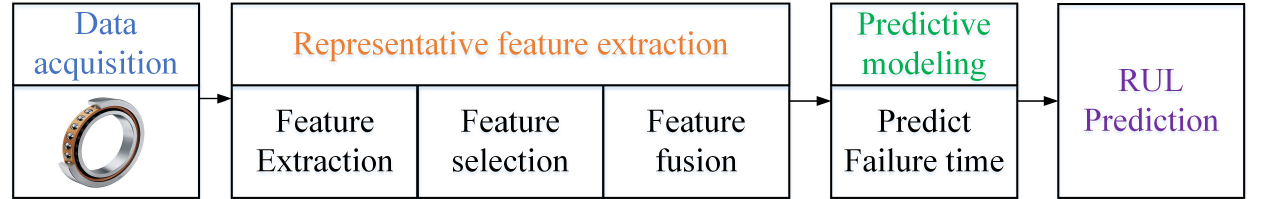
Figure 2. Data-driven based RUL